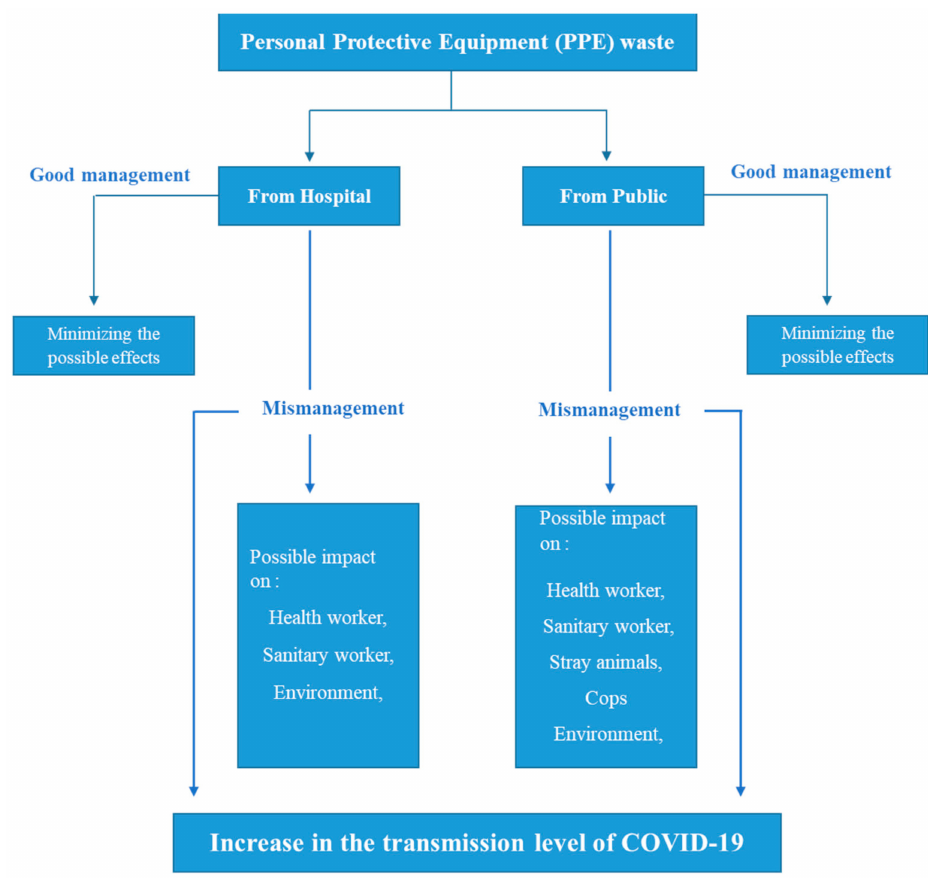
Figure 2. The possible impacts of mismanagement of personal protective